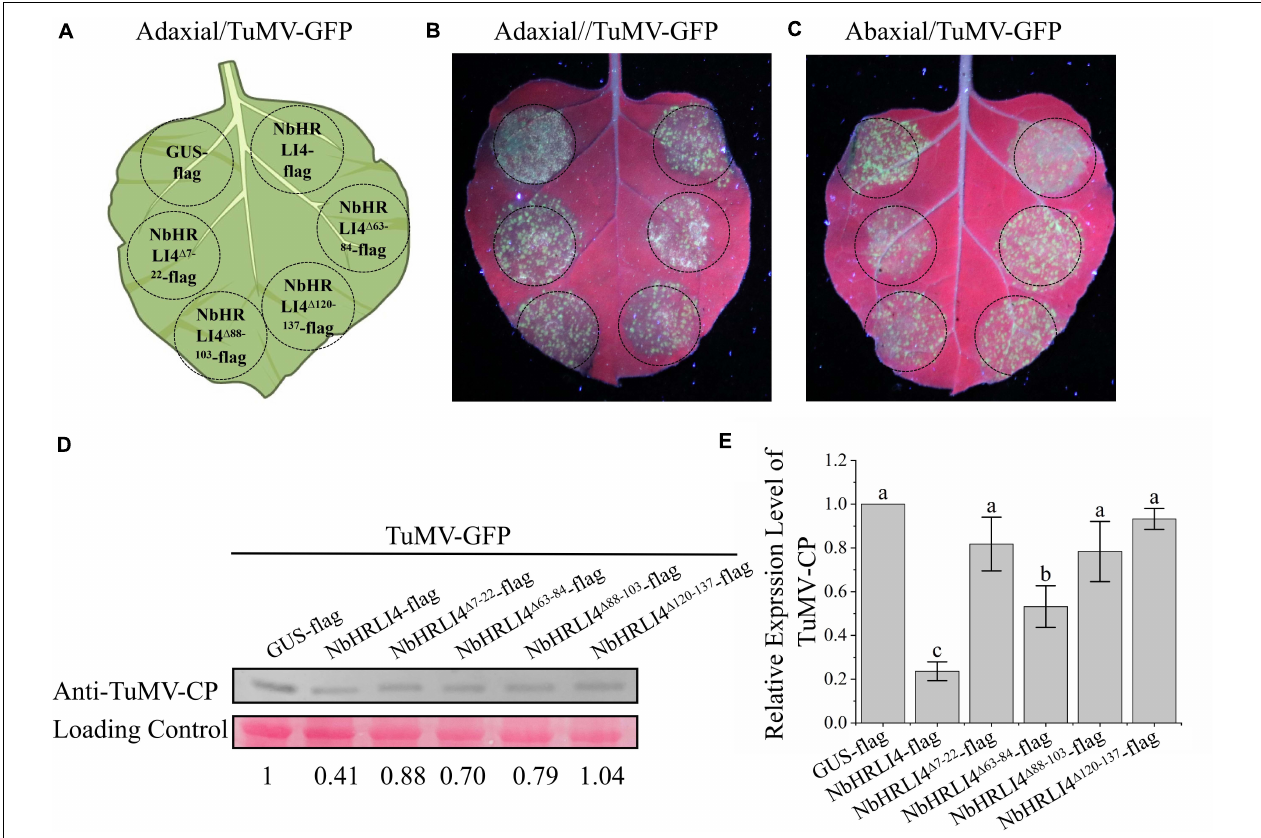
FIGURE 9 | The membrane interaction domains of NbHRLI4 are essential for resistance to TuMV. (A) Schematic diagram showing transient infiltration of GUS-flag, NbHRLI4-flag, NbHRLI4 (cid:49) 7 − 22 -flag, NbHRLI4 (cid:49) 63 − 84 -flag, NbHRLI4 (cid:49) 88 − 103 -flag, and NbHRLI4 (cid:49) 120 − 137 -flag combined with TuMV in panels (B,C) . (B) Adaxial surface of leaves expressing the vectors in panel (A) under UV light at 4 dpi. (C) Abaxial surface of leaves expressing the vectors in panel (A) under UV light at 4 dpi. (D) Western blotting detection of TuMV-CP on leaves shown in panels (B,C) . (E) Results of RT-qPCR to detect TuMV mRNA in leaves shown in panels (B,C) . The mean expression values were analyzed using F -test. Different letters on histograms indicate significant differences ( P < 0.05).